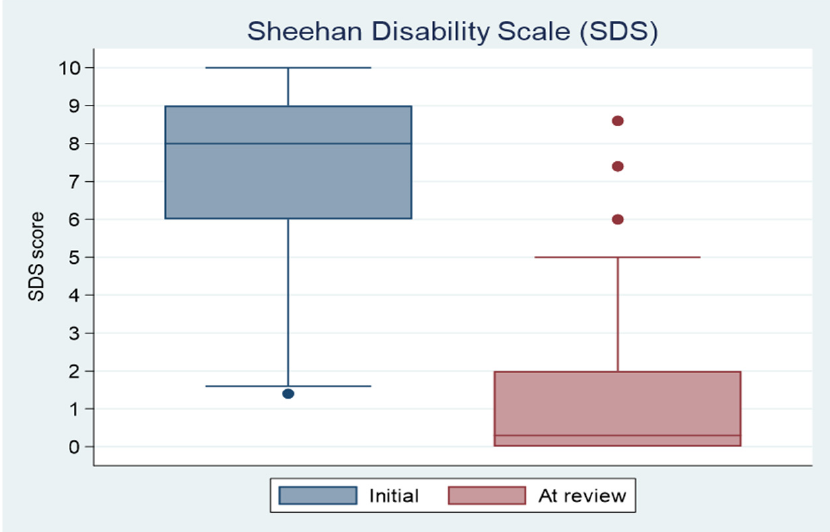
Figure 1. Box plots of severity of dependence scale (SDS) at start of treatment and at time of review. The central mark of the box shows the median value of the scores and the lower and upper top edges of the box indicate the 25th and 75th percentiles, respectively. Outliers are designated with a dot. The whiskers show the most extreme data points not considered outliers.